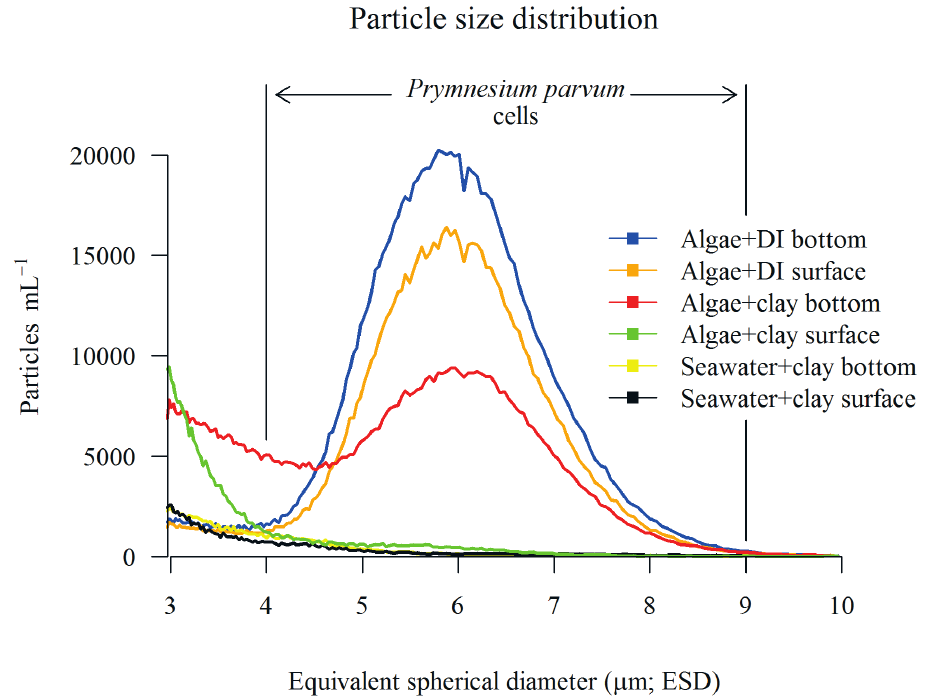
Figure 3. Particle size distribution in surface and bottom samples 4 h after Phoslock™ (B3) addition to P. parvum cultures. Cultures were treated with 1 g L − 1 Phoslock™ slurry (black and orange lines represent top and bottom samples, respectively) and control cultures with an equal amount of deionized water (DI; red and blue lines represent top and bottom samples, respectively). To facilitate the interpretation of the results, a further control of 1 g L − 1 Phoslock™ clay in seawater (no algae) was employed (yellow and black lines represent bottom and surface samples, respectively). The particle size range corresponding to P. parvum cells is indicated (4–9 μ m